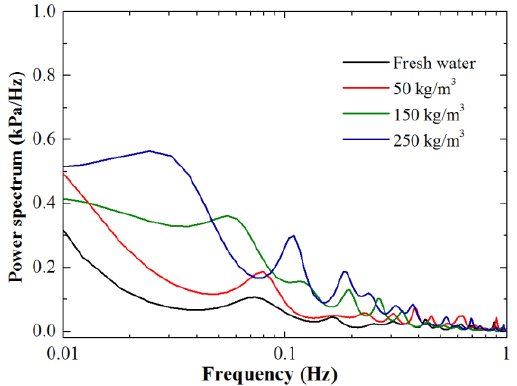
Figure 11. Relationships between power spectrum and frequency with an upstream water head of 1.90 m for different sediment concentrations.